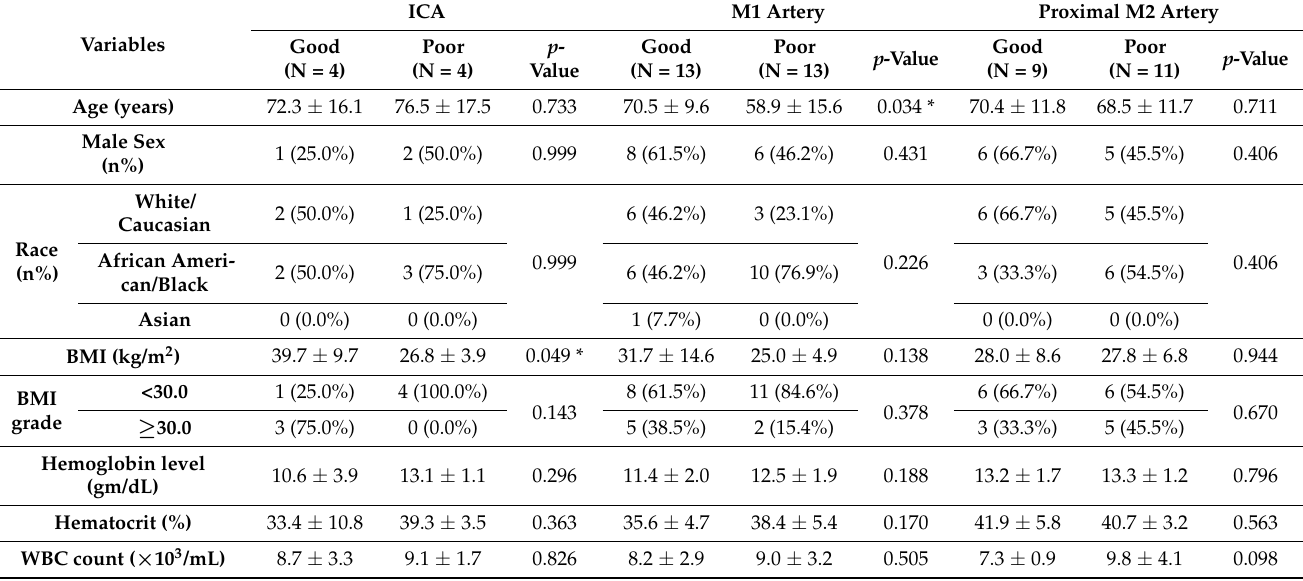
Figure 1. Comparison of BMI in patients with poor vs. good collaterals. The comparison in the CS of patients with occlusions in different arterial territories and their relationship to baseline characteristics is shown in Table 3. Age was significantly higher (70.5 ± 9.6 vs. 58.9 ± 15.6; p = 0.034) in patients with poor CS and M1 strokes, and BMI was significantly higher (39.7 ± 9.7 vs. 26.8 ± 3.9; p = 0.049) in patients with ICA occlusions and good CS. Right sided proximal M2 occlusions were significantly more common in patients with poor CS (63.6% (7/11) vs. 11.1% (1/9); p = 0.028) than those with good CS. Diagnostic performance based on vessel subgroup is shown in Table 4. Table 3. Comparison in the collateral status of patients with occlusions in different arterial territories and their relationship to baseline characteristics.